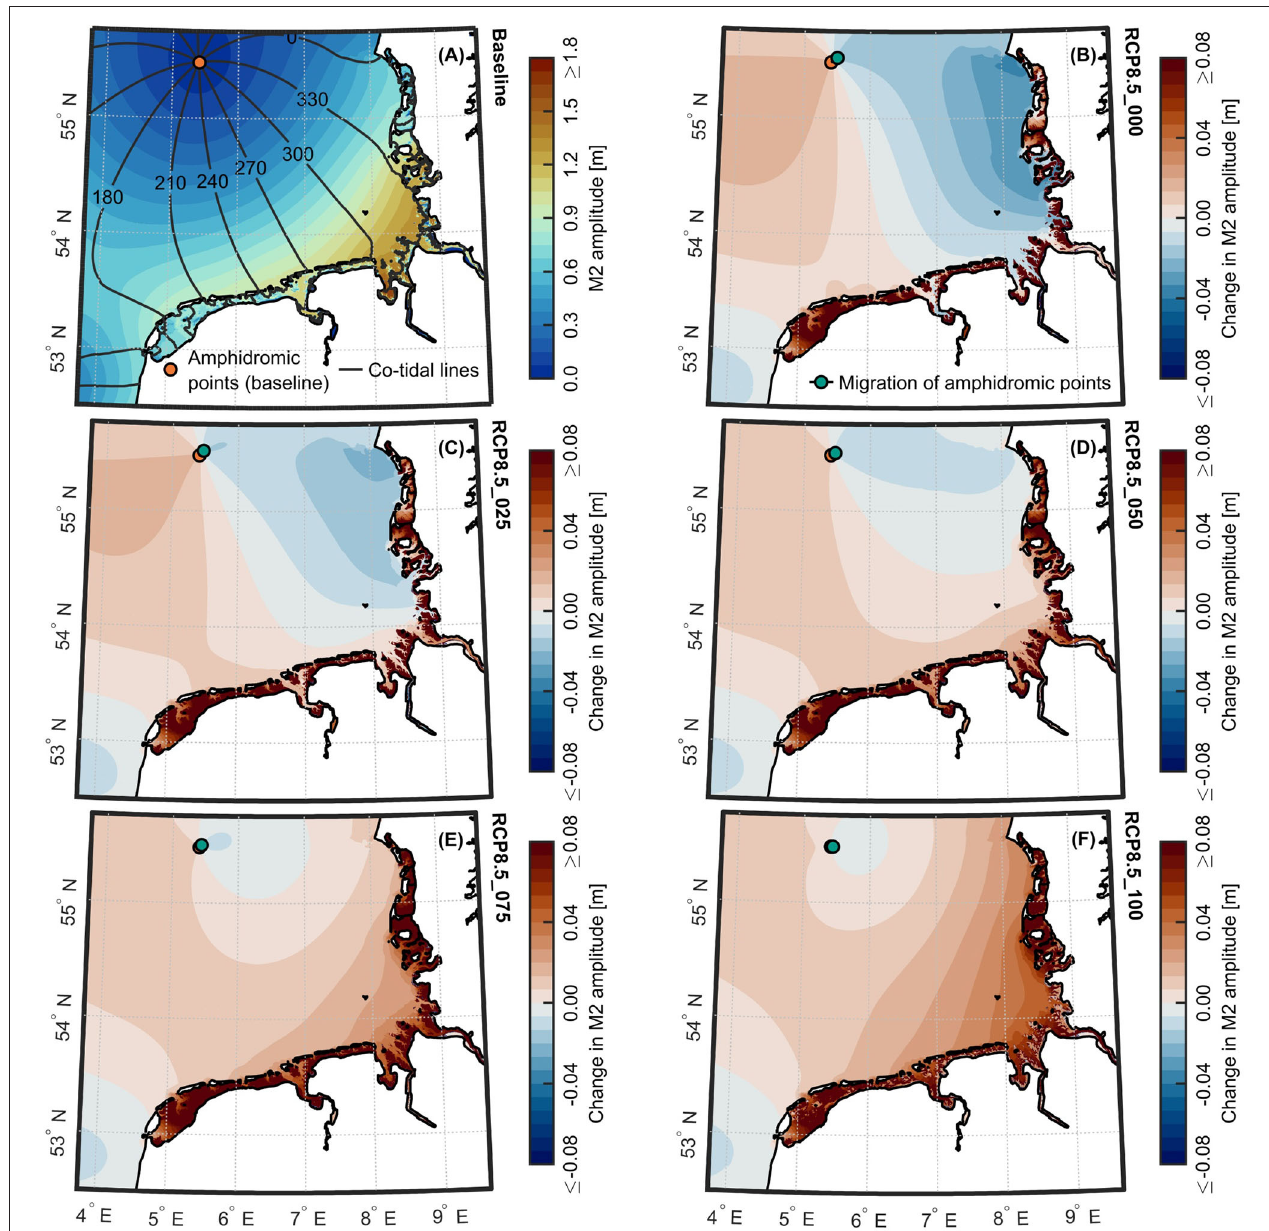
FIGURE 7 | M2 amplitudes for the Wadden Sea resulting from the combinations of 0.8m SLR projection and various cumulative rates of vertical accretion. (A) Map of M2 amplitudes for the Wadden Sea for the baseline scenario, according to the 3-month period from September 1 to December 1, 2012. Relative changes in M2 amplitudes for scenarios (B) RCP8.5_000, (C) RCP8.5_025, (D) RCP8.5_050, (E) RCP8.5_075, and (F) RCP8.5_100. Green dots indicate movements of amphidromic points in relation to the baseline scenario (orange